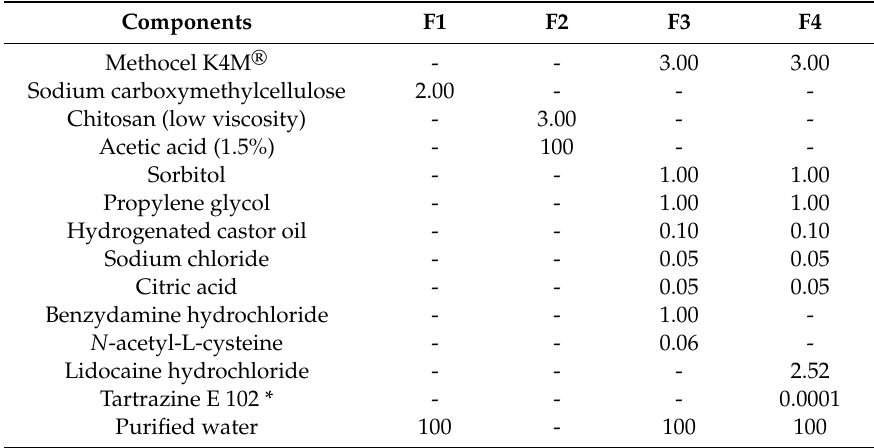
Table 1. Composition of polymeric gel-like solution F1, F2, F3, and F4.